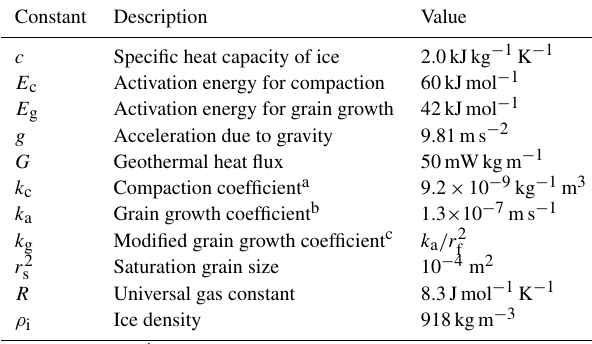
Table 1. Model variables and coordinates. Variable